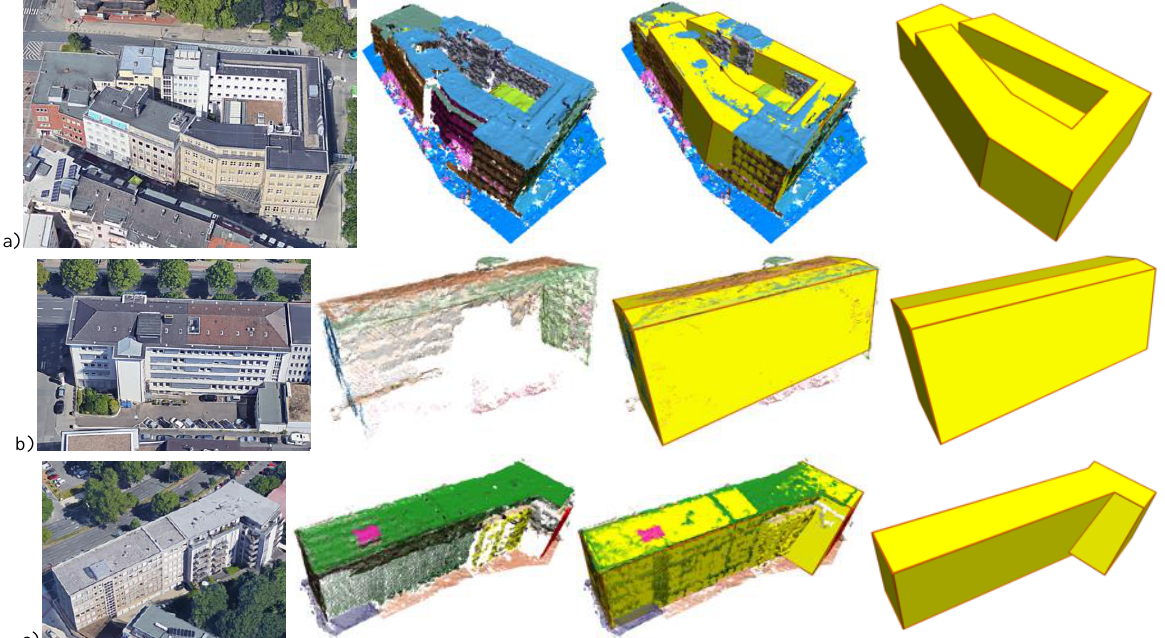
c) Figure 10. Examples of 3D reconstructions for different buildings extracted from the Dortmund point cloud. Some façade or roof details, if not well surveyed by the point cloud, are not correctly modelled.